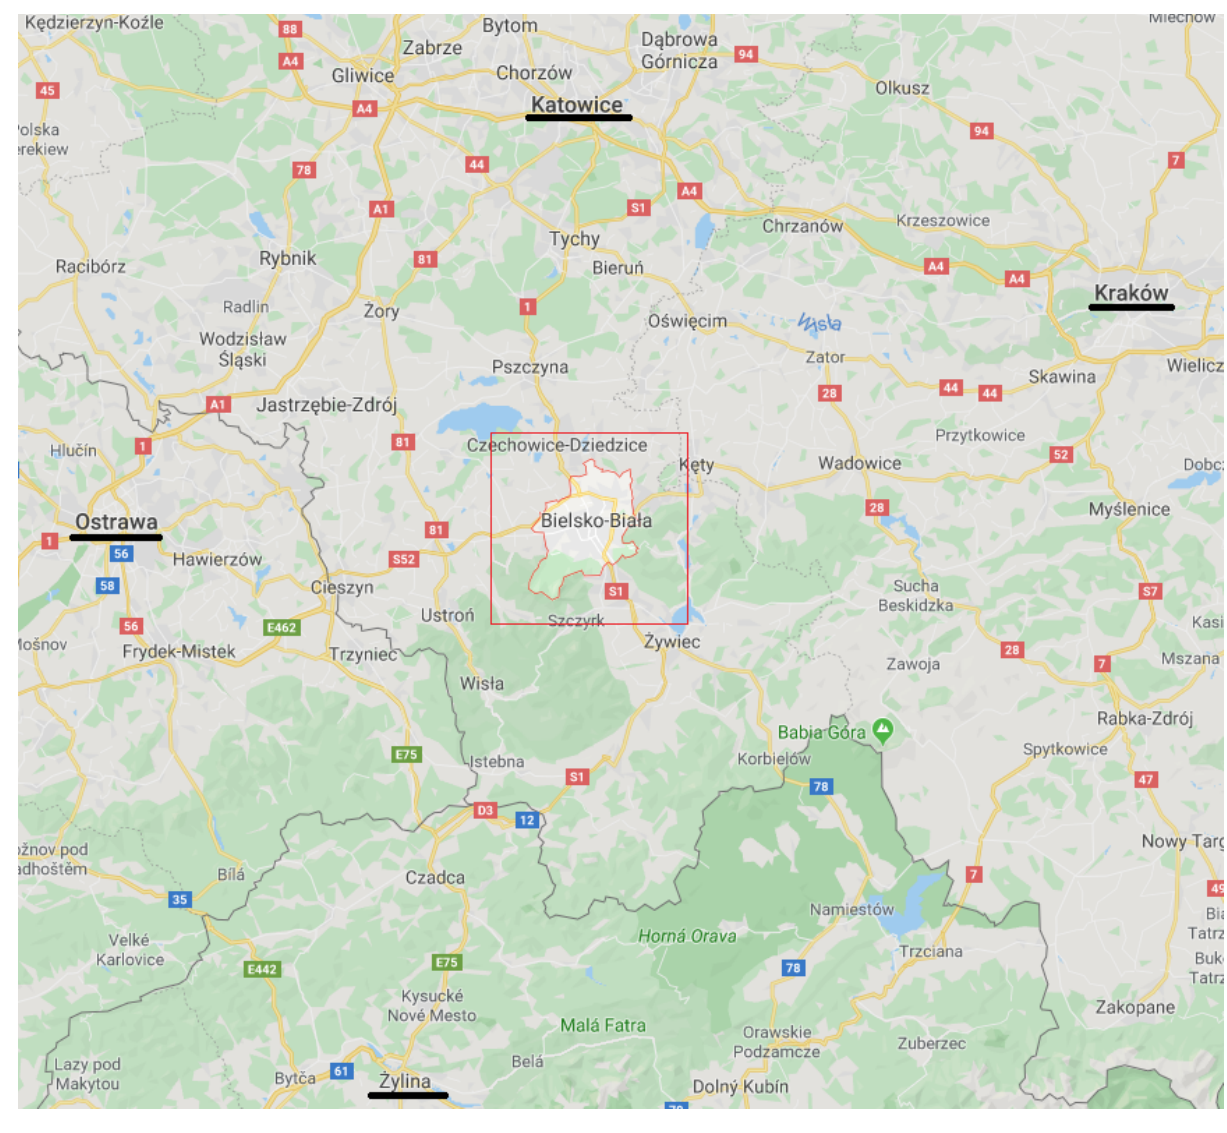
Figure 3: Location of Bielsko-Biala City [source: Google Maps]